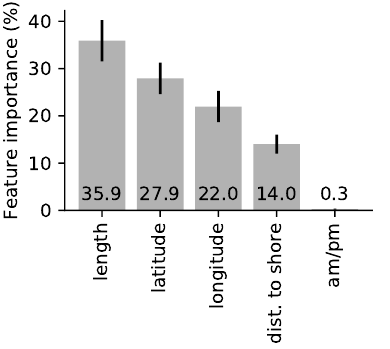
Figure 9. Feature importance of the trained Random Forest. The error bar is the standard deviation of the feature importance over the ensemble of decision